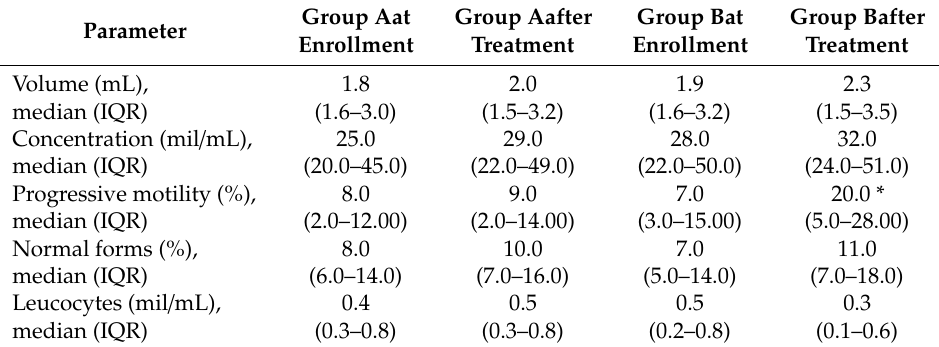
Table 2. Sperm parameters before and after 4 months of pharmacological